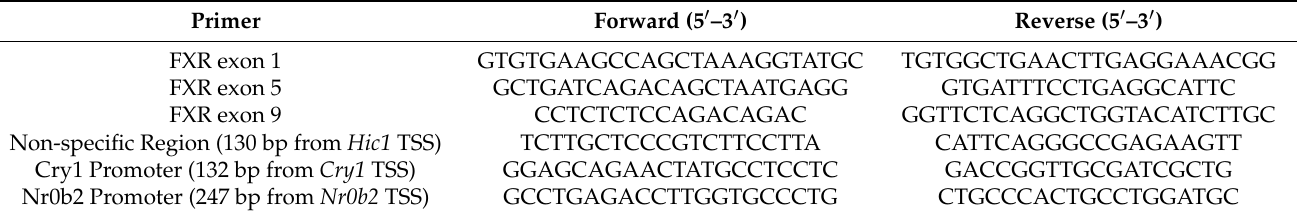
Table 3. Primers for RT-PCR and